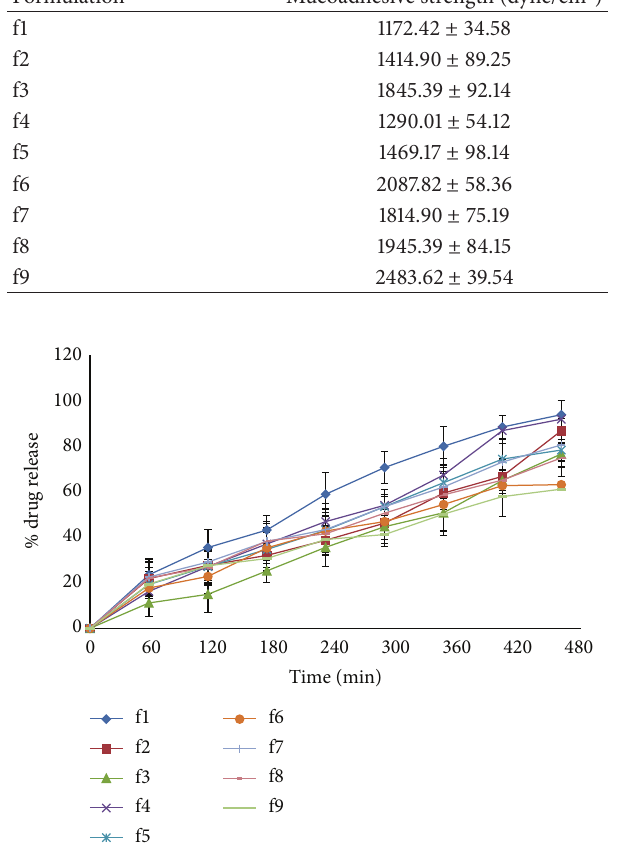
Table 5: Mucoadhesive strength of batch f1–f9. Formulation